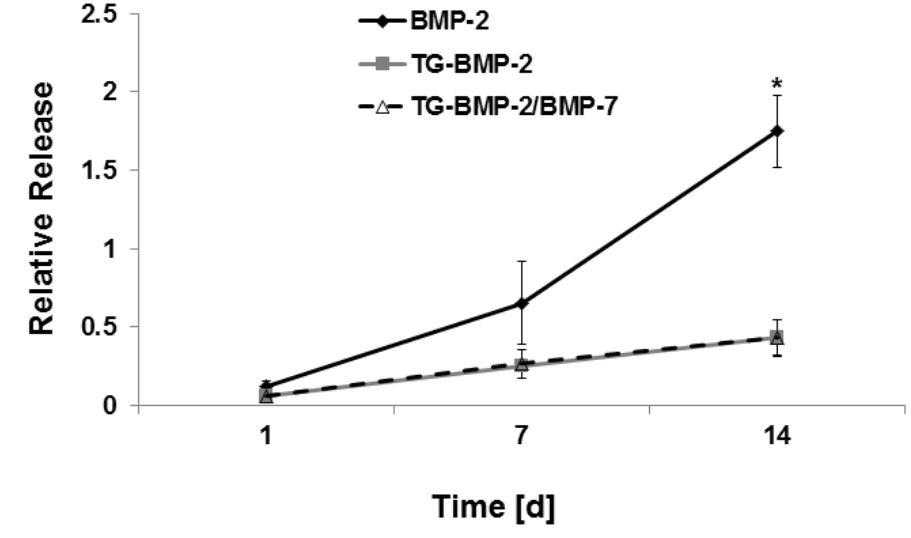
Figure 5. In vitro cumulative release from fibrin over days in DMEM normalized to the growth factor alone * p <